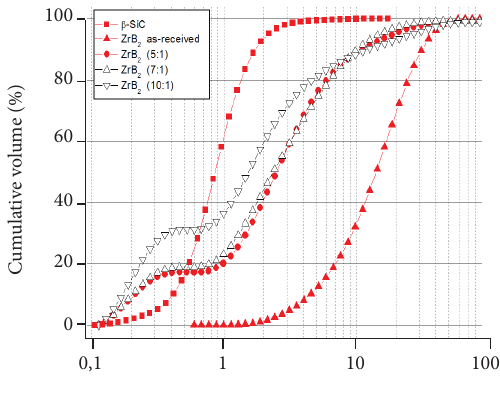
Figure 1. Particle size distribution of SiC as-received and milled ZrB The used powders to prepare the composites are in red